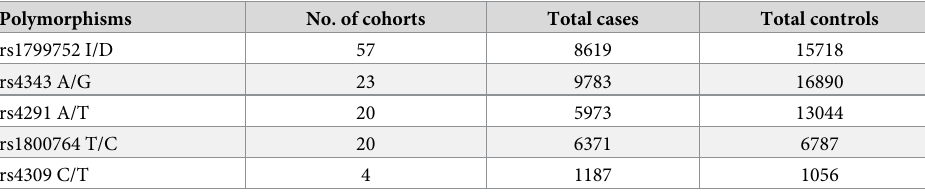
Table 2. Summary of ACE polymorphisms included in the present